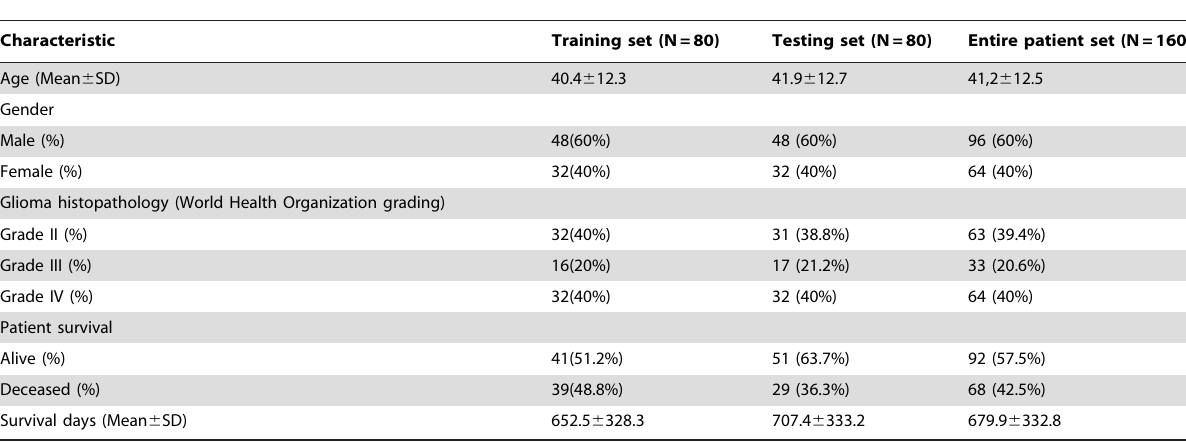
Table 1. Clinicopathological characteristics of patients in the training set, the testing set, and entire patient set.